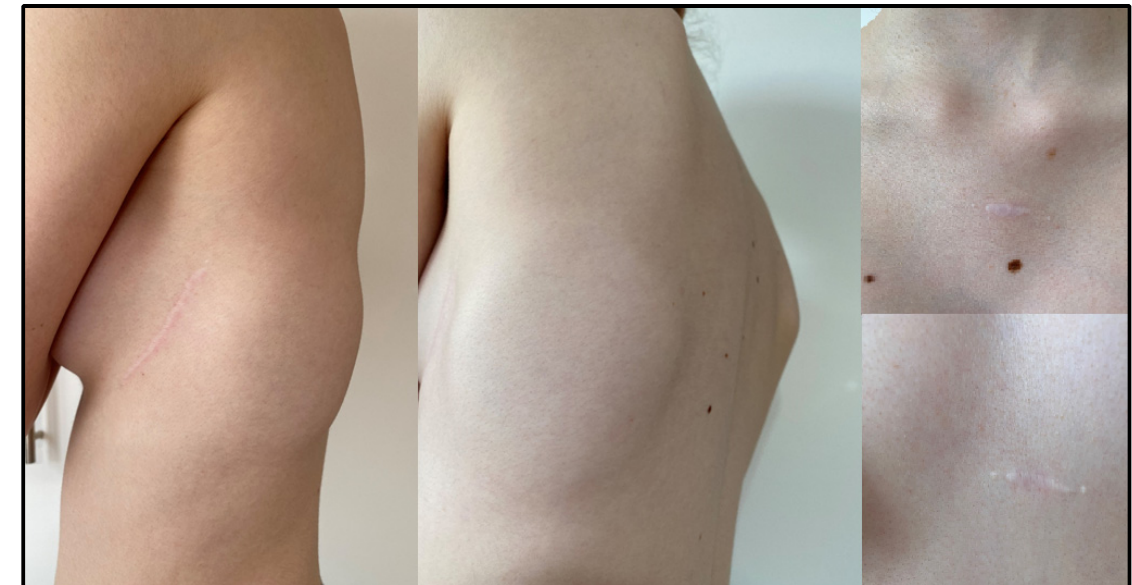
Figure 3. Patient 8. Cosmetic effect after S-ICD implantation in a 14-year-old female patient after cardiac arrest by ventricular fibrillation. S-ICD, subcutaneous implantable cardioverter defibrillator.